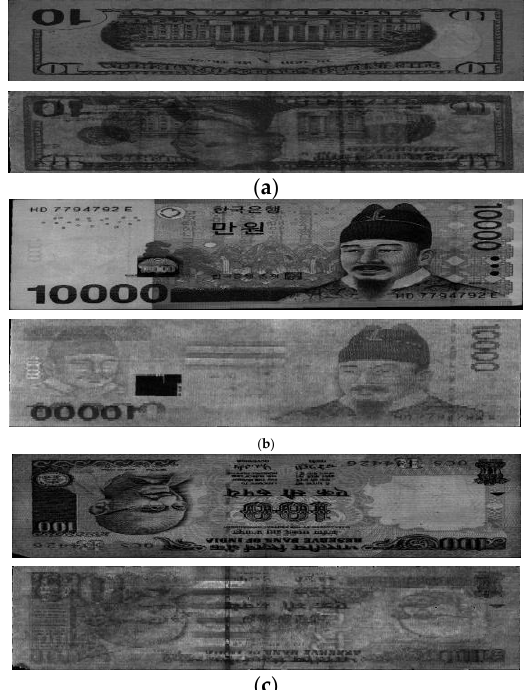
Figure 12. Examples of incorrectly recognized cases (Type I error) by our method on: ( a ) USD; ( b ) KRW; ( c ) INR. In (a–c), upper and lower figures represent the VR and NIRT images, respectively.